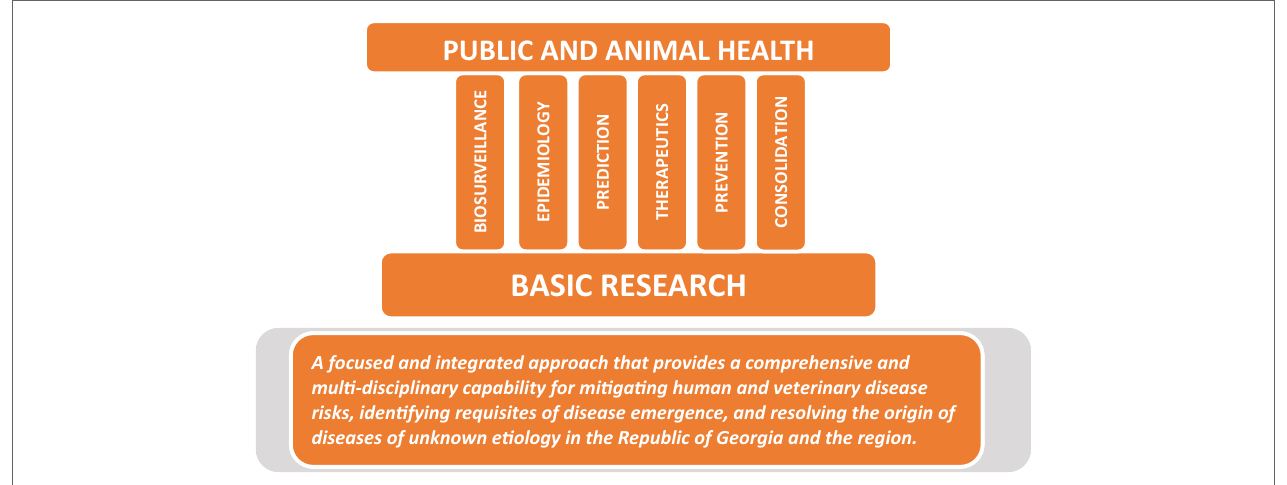
FiGURe 3 | Focus groups . The POE Implementation Plan envisioned Focus Groups as pillars to ensure strong linkage between the needs of the public and animal health identified issues and the basic research program conducted at the CPHR enhancing the ability of the health sector to respond to disease outbreaks and providing relevance to the research